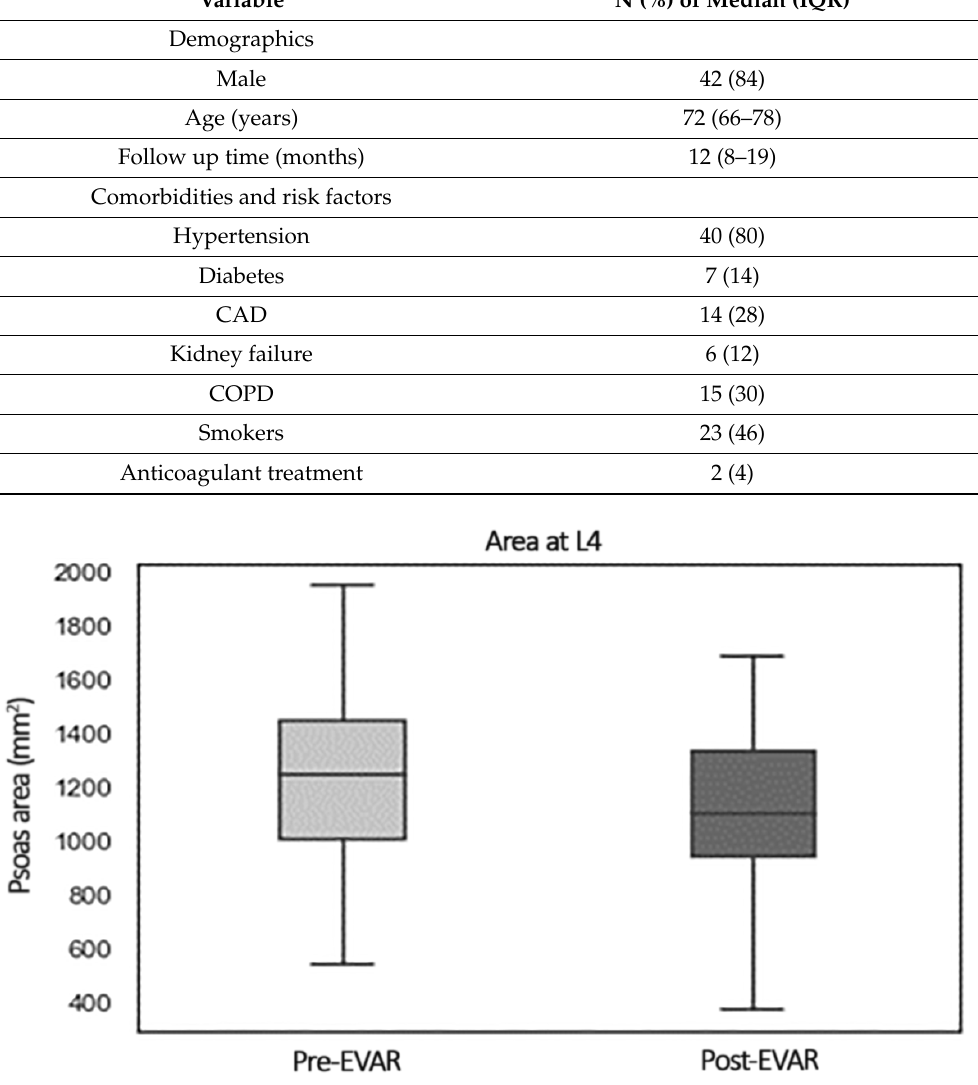
Figure 2. Box plot showing comparison of PMA before and after EVAR.